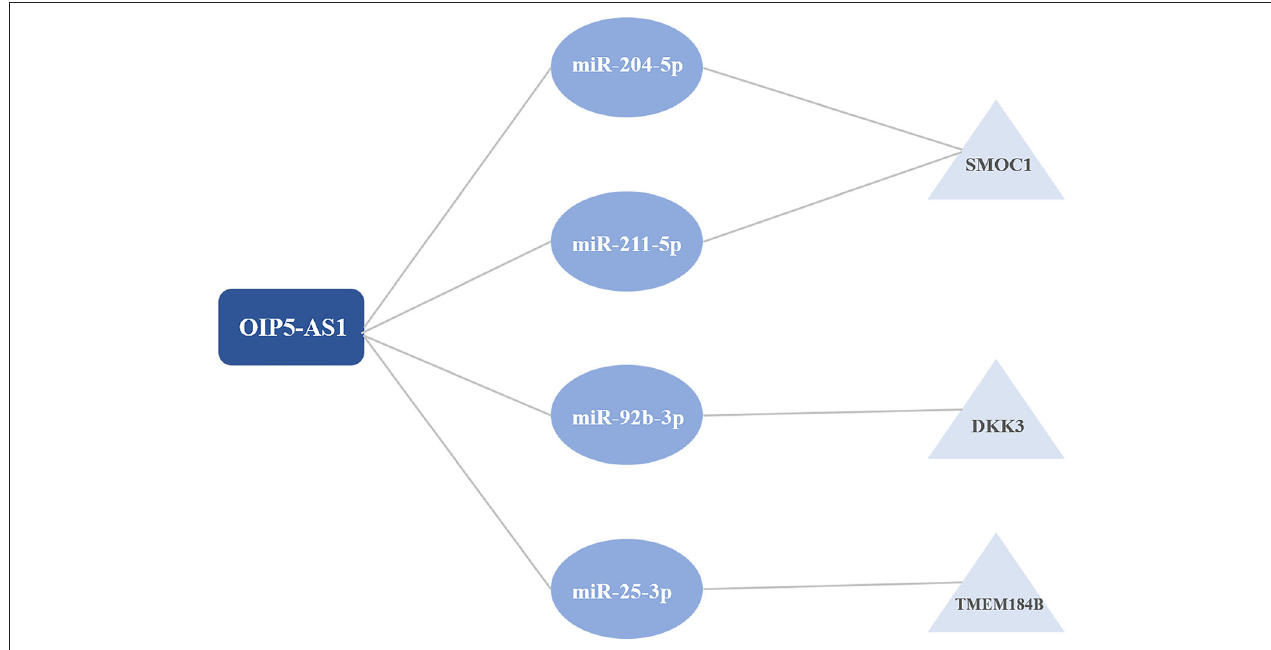
FIGURE 5 | The competitive endogenous RNA (ceRNA) regulatory networks.